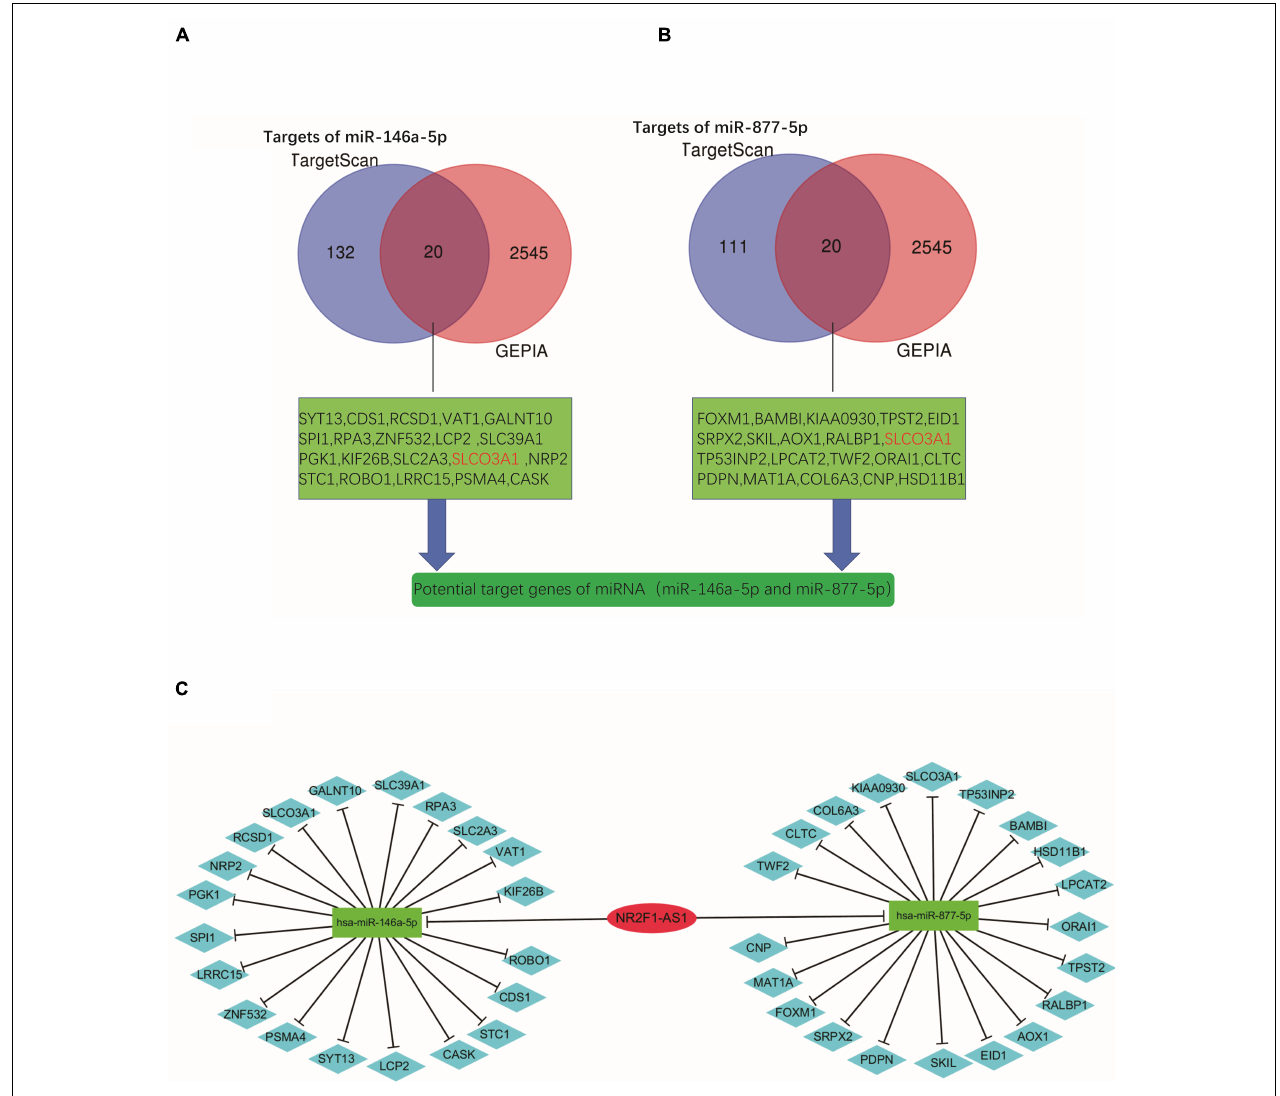
FIGURE 6 | Preliminary construction of a novel lncRNA-miRNA-mRNA (ceRNA) regulatory network. (A,B) Venn analysis for preliminary identification of potential target genes by combining prediction analyses and expression using TargetScan7.2 and GEPIA databases. (C) Construction of the lncRNA-miRNA-gene network using Cytoscape